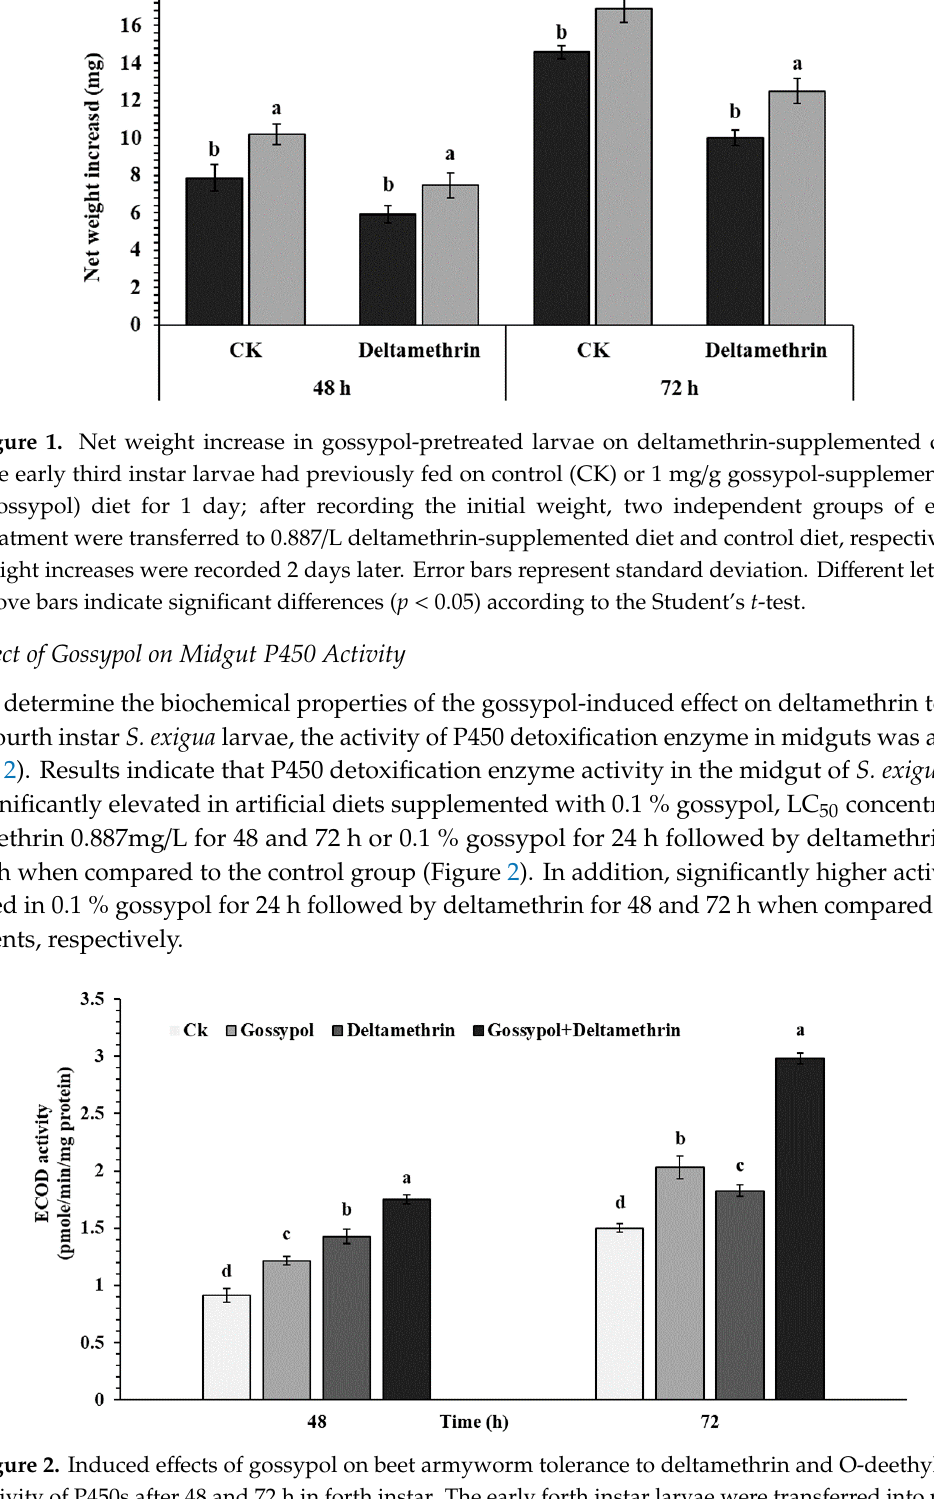
Figure 2. Induced effects of gossypol on beet armyworm tolerance to deltamethrin and O-deethylase activity of P450s after 48 and 72 h in forth instar. The early forth instar larvae were transferred into new sterilized plastic cups containing artificial diets supplemented with 0.1 % gossypol, LC 50 concentration of deltamethrin 0.887mg / L for 48 and 72 h or 0.1 % gossypol for 24 h followed by deltamethrin for 48 bars indicate significant di ff erences ( p < 0.05) according to the Tukey HSD